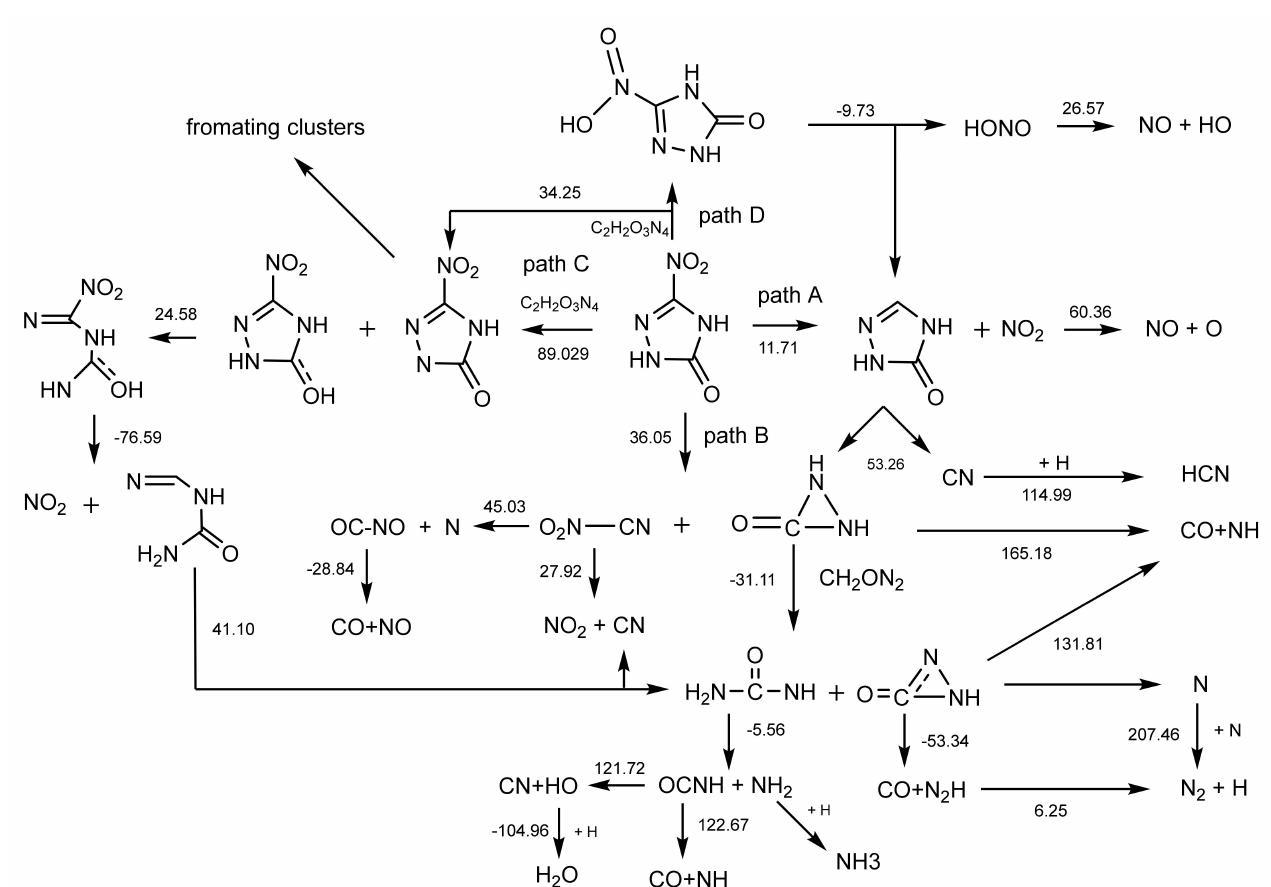
Figure 9. The initial decomposition paths of